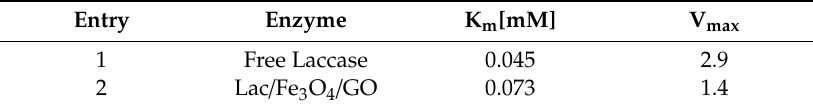
Table 1. Parameters investigated for free laccase and Lac/Fe 3 O 4 /GO.